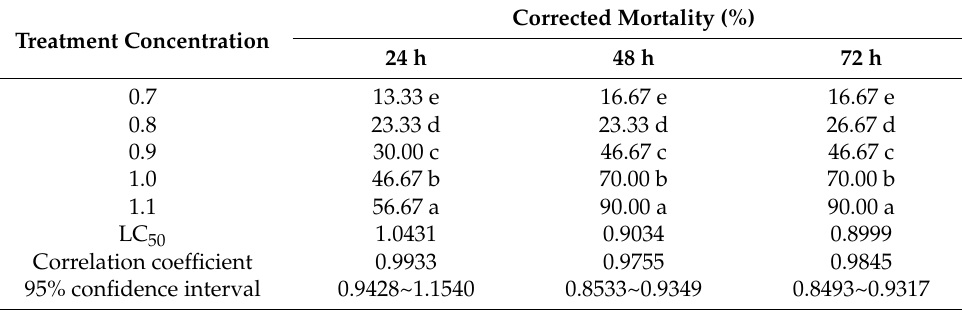
Table 2. Immersion toxicity effect of different concentrations of NI for P. canaliculata .